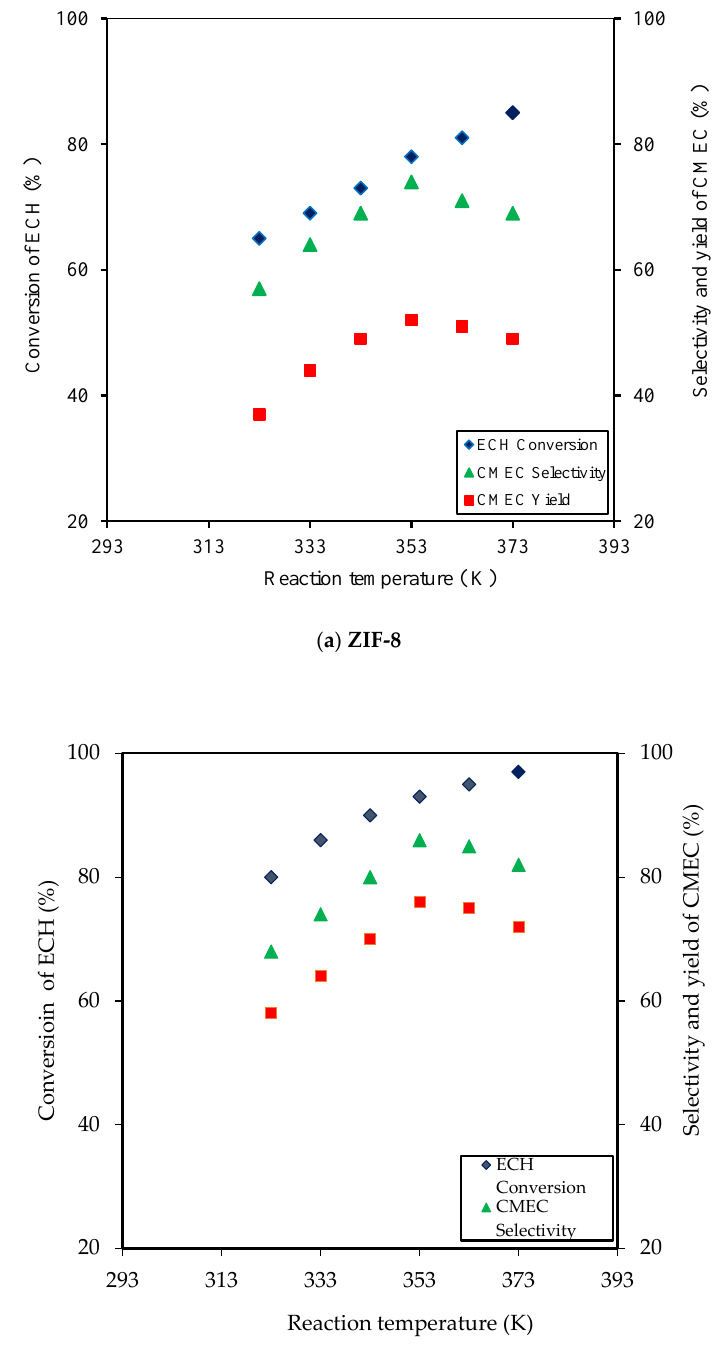
Figure 13. Temperature dependence on conversion of ECH versus selectivity and yield of CMEC. Experimental conditions: catalyst ( a ) ZIF-8 and ( b ) Zr/ZIF-8; catalyst loading 10% ( w/w ); reaction time 8 h; CO 2 pressure 8 bar; stirring speed 350 rpm.